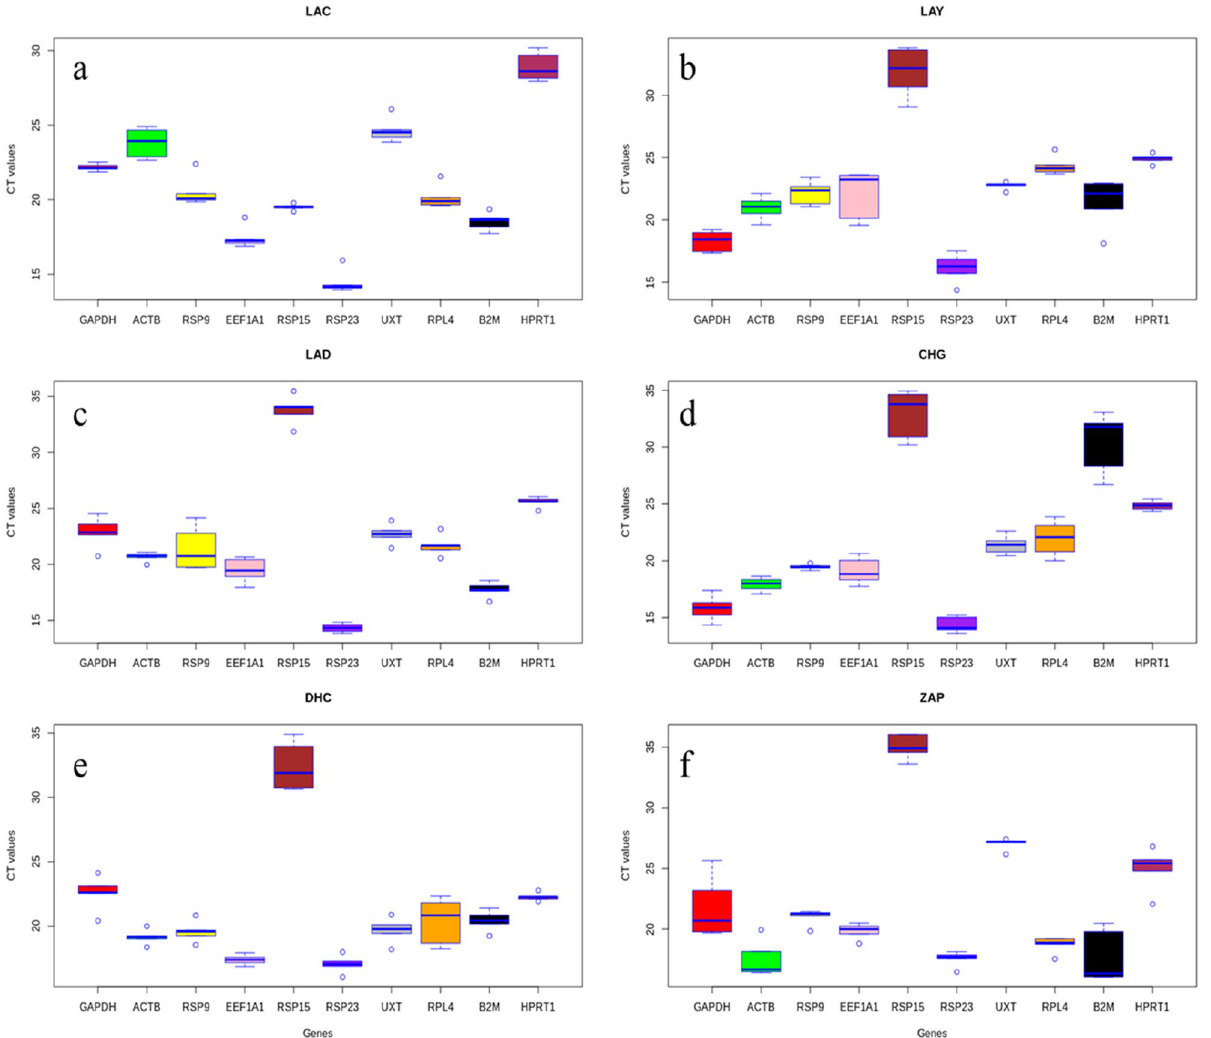
Figure 1. Expression level of individual candidate RGs in LAC ( a ), LAY ( b ), LAD ( c ), CHG ( d ), DHC ( e ) and ZAP ( f ). The data is presented as quantification cycle (Ct) values of each gene in the box-whisker diagram. The median is shown as a line across the box while whiskers indicate maximum and minimum